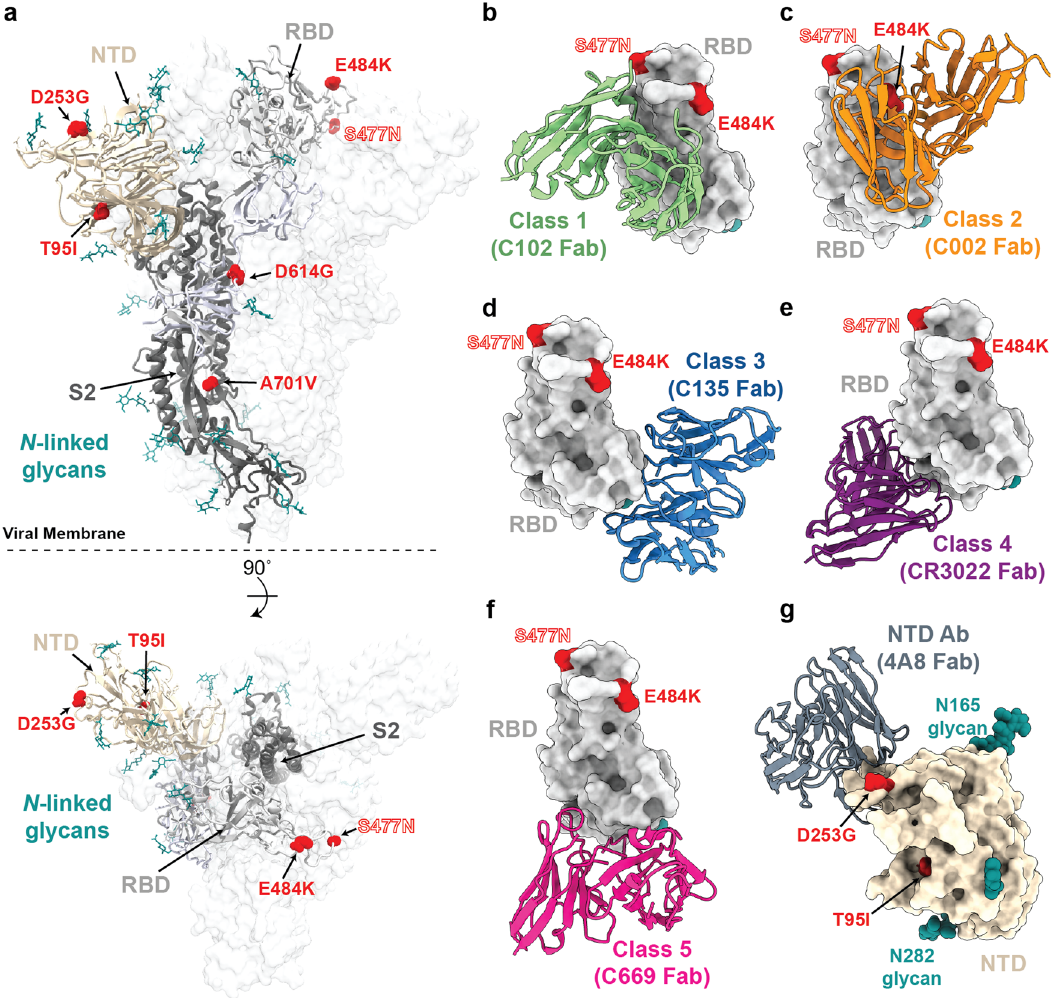
Fig. 2 Structural locations of the spike mutations of lineage B.1.526. a Side and top views of the SARS-CoV-2 spike trimer (PDB 7JJI) with mutations of lineage B.1.526 shown as spheres. b – g Models of representative neutralizing antibodies (cartoon, VH-VL domain only) bound to RBD ( b – f , gray surface) or NTD ( g , wheat surface). Sites for B.1.526 lineage mutations are shown as red spheres, N -linked glycans are shown in cyan. The S477N site is also shown (label outlined) for the branch containing this mutation instead of the E484K mutation (see Fig. 1); b Class 1 (PDB 7K8M); c Class 2 (PDB 7K8S); d Class 3 (PDB 7K8Z); e Class 4 (PDB 6W41); f Class 5 8 ; g NTD-speci fi c antibody 4A8 (PDB 7C2L).